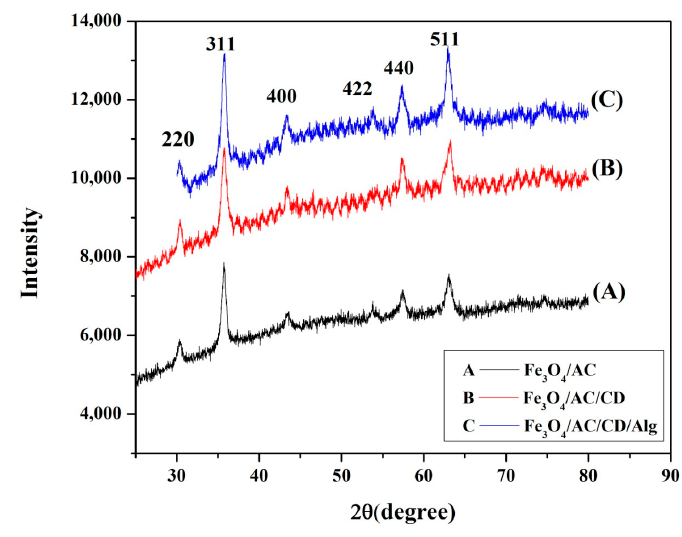
Figure 3. X-ray diffractograms of Fe 3 O 4 /AC ( A ), Fe 3 O 4 /AC/CD ( B ) and Fe 3 O 4 /AC/CD/Alg ( C ).